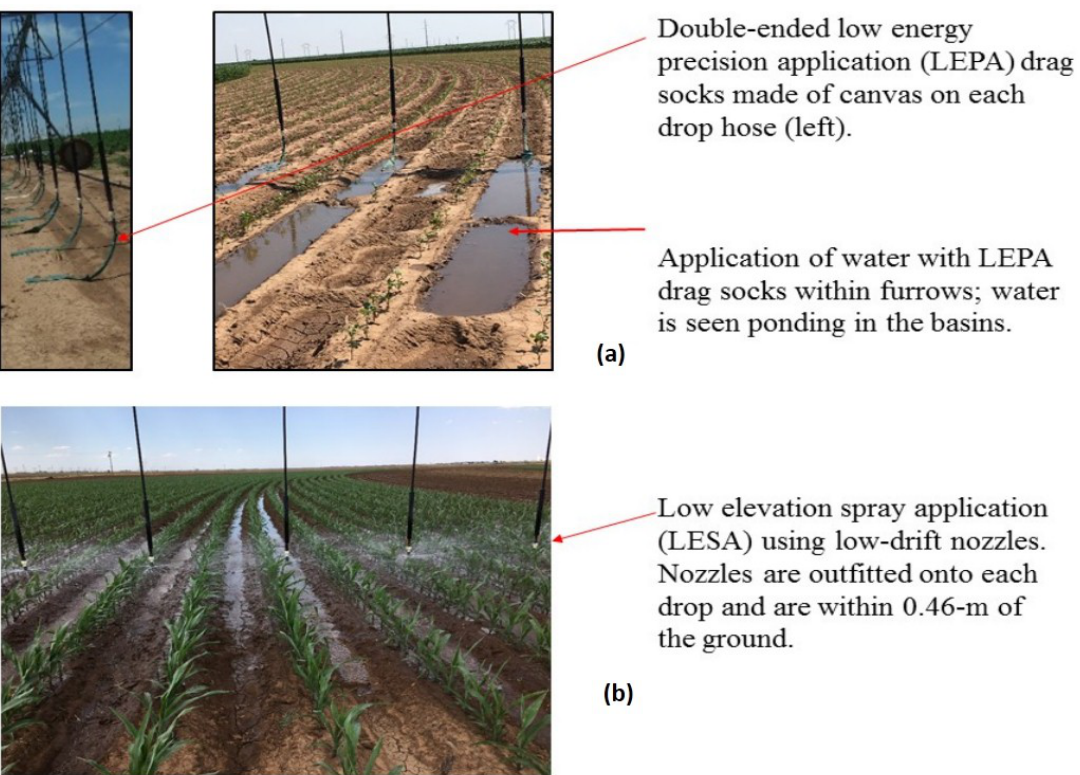
Figure 3. Application methods commonly used on center pivot systems in the Texas High Plains region